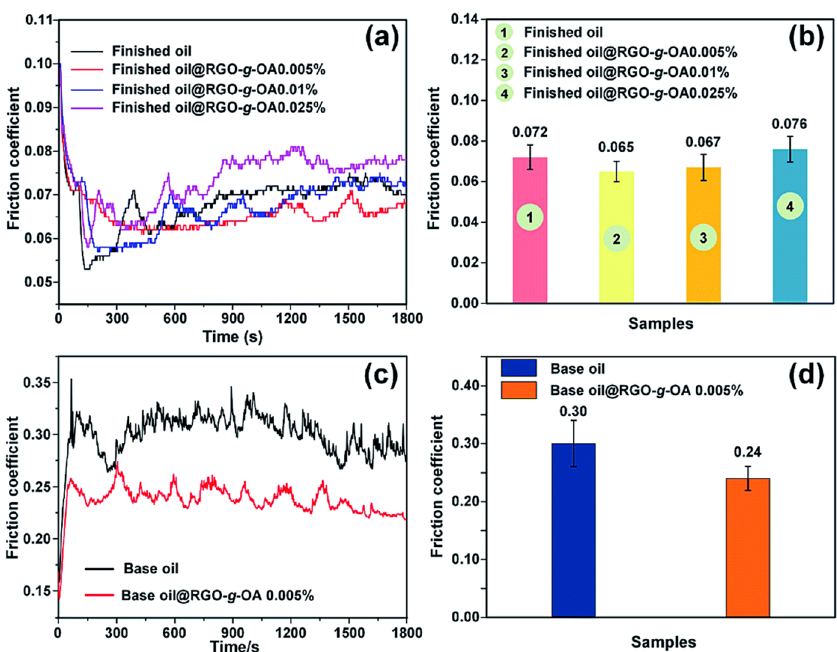
Figure 8. ( a , c ) Typical friction coefficients with time and ( b , d ) average friction coefficients of pristine finished oil, base oil and the ones filled with various mass contents of RGO-g-OA on steel discs; the load applied is 100 N. Reproduced with permission from [61]. Copyright 2019 Royal Society of Chemistry.